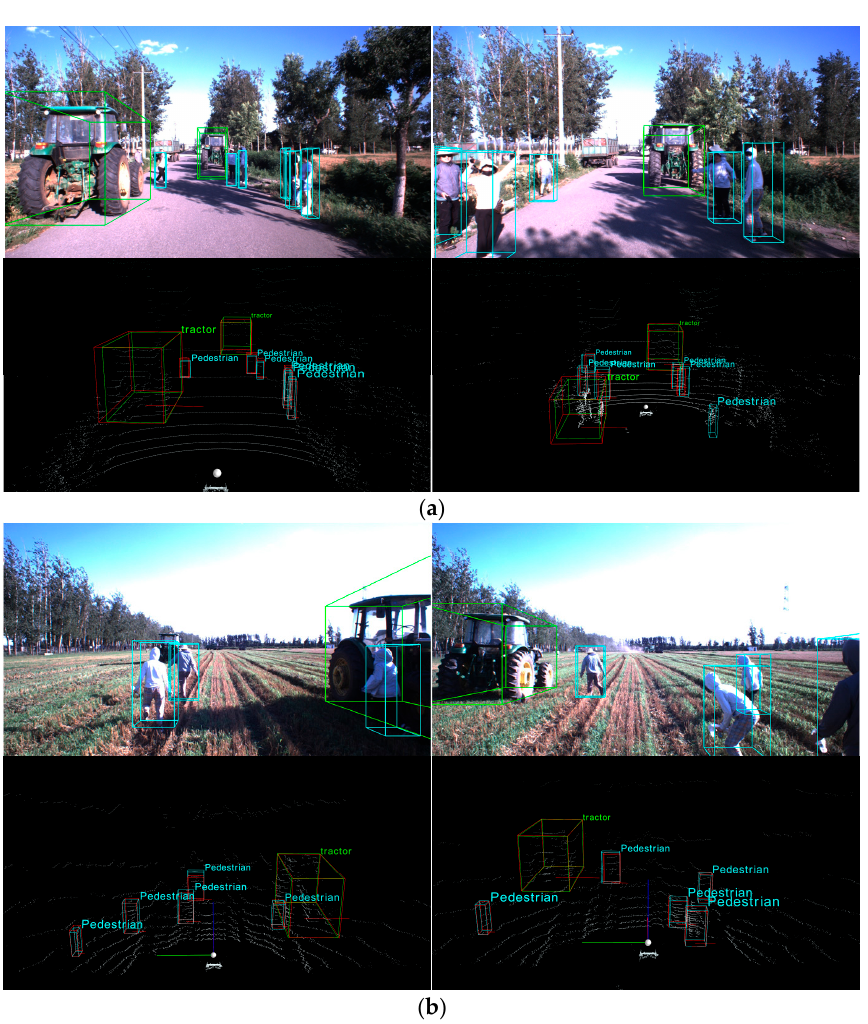
Figure 10. Visualization of obstacle detection results in different scenes. For each sample, the upper part shows the 3D detection boxes projected to the image, while the lower part shows the 3D detection results from the point cloud. ( a ) Agricultural road scene. ( b ) Field scene.